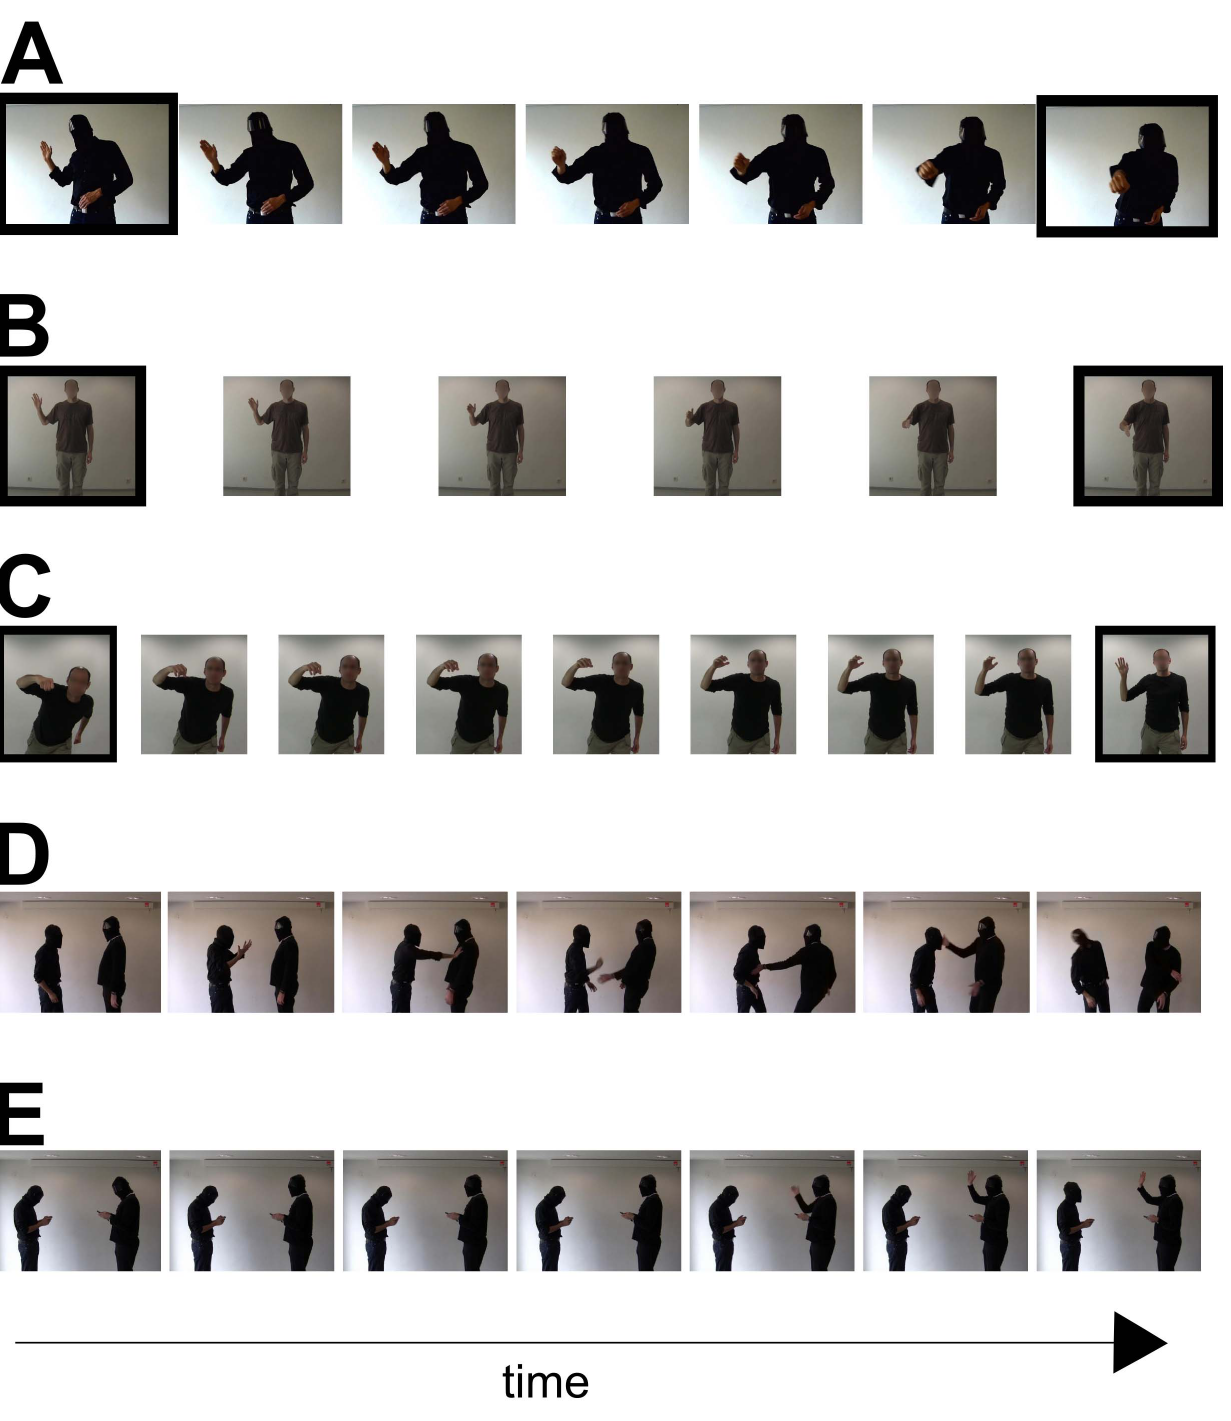
Figure 1. Example stimuli. A . Test stimuli of experiment 1 and 2. The images with the black borders also served as adaptors in experiment 1. B . Test stimuli of the same emotion condition of experiment 3. Black borders indicate the images that were used as adaptor stimuli. C . Test stimuli of the different emotion condition experiment 3 and experiment 4. The images with the black borders served as adaptors in experiment 3 only. D. Stills of the hitting video. The left person pushed the right person (stills 1 to 4), who in return slapped the left person (stills 5–7). Still 5 shows the apex of the swing before the actual slap of the right person. E. Stills of the the waving video. The left person is looking up (still 2) and starts waving at the right person (stills 5–7). The time line only applies to panel D and E. total seven frames were rendered from this video. The first frame Stimuli and Apparatus. Test and adaptor images were rendered from a video showing a person changing his body (showing a static hand-up posture) and the last frame (showing a posture from a hand-up posture to a hitting posture (Figure 1A). In static hitting posture) served as adaptor stimuli. All seven stimuli in